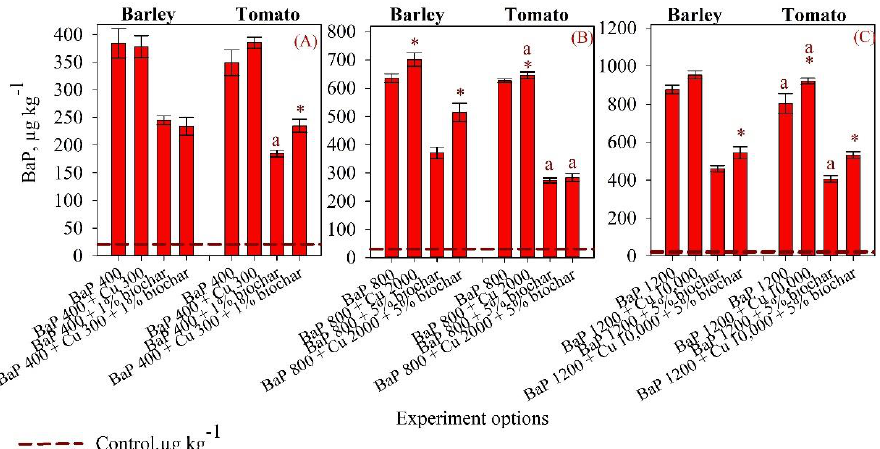
− 1 of BaP alone and co-